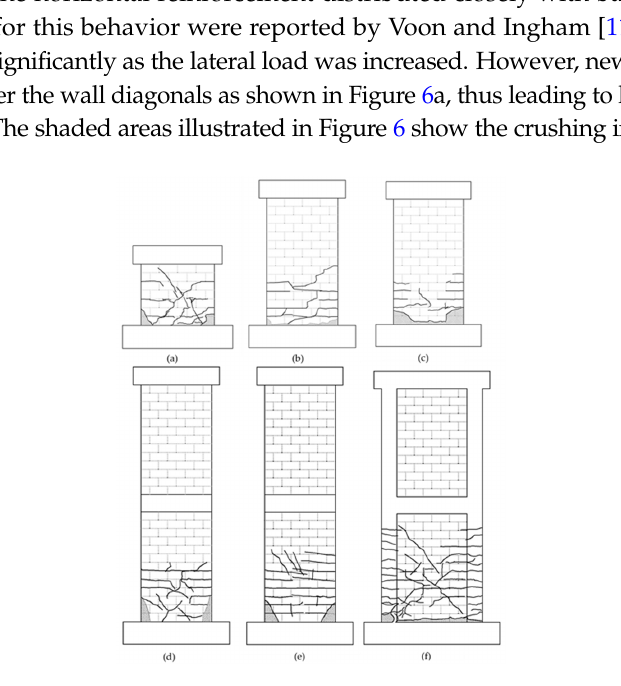
Figure 6. SCMSW specimen cracking patterns: ( a ) SW1; ( b ) SW2; ( c ) SW3; ( d ) SW4; ( e ) SW5; and ( f ) SW6.